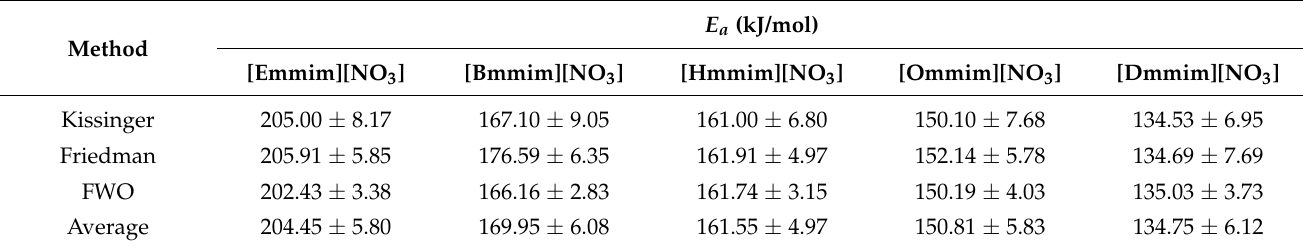
Table 6. The activation energy of the 1-alkyl-2,3-dimethylimidazole nitrate ionic liquids.